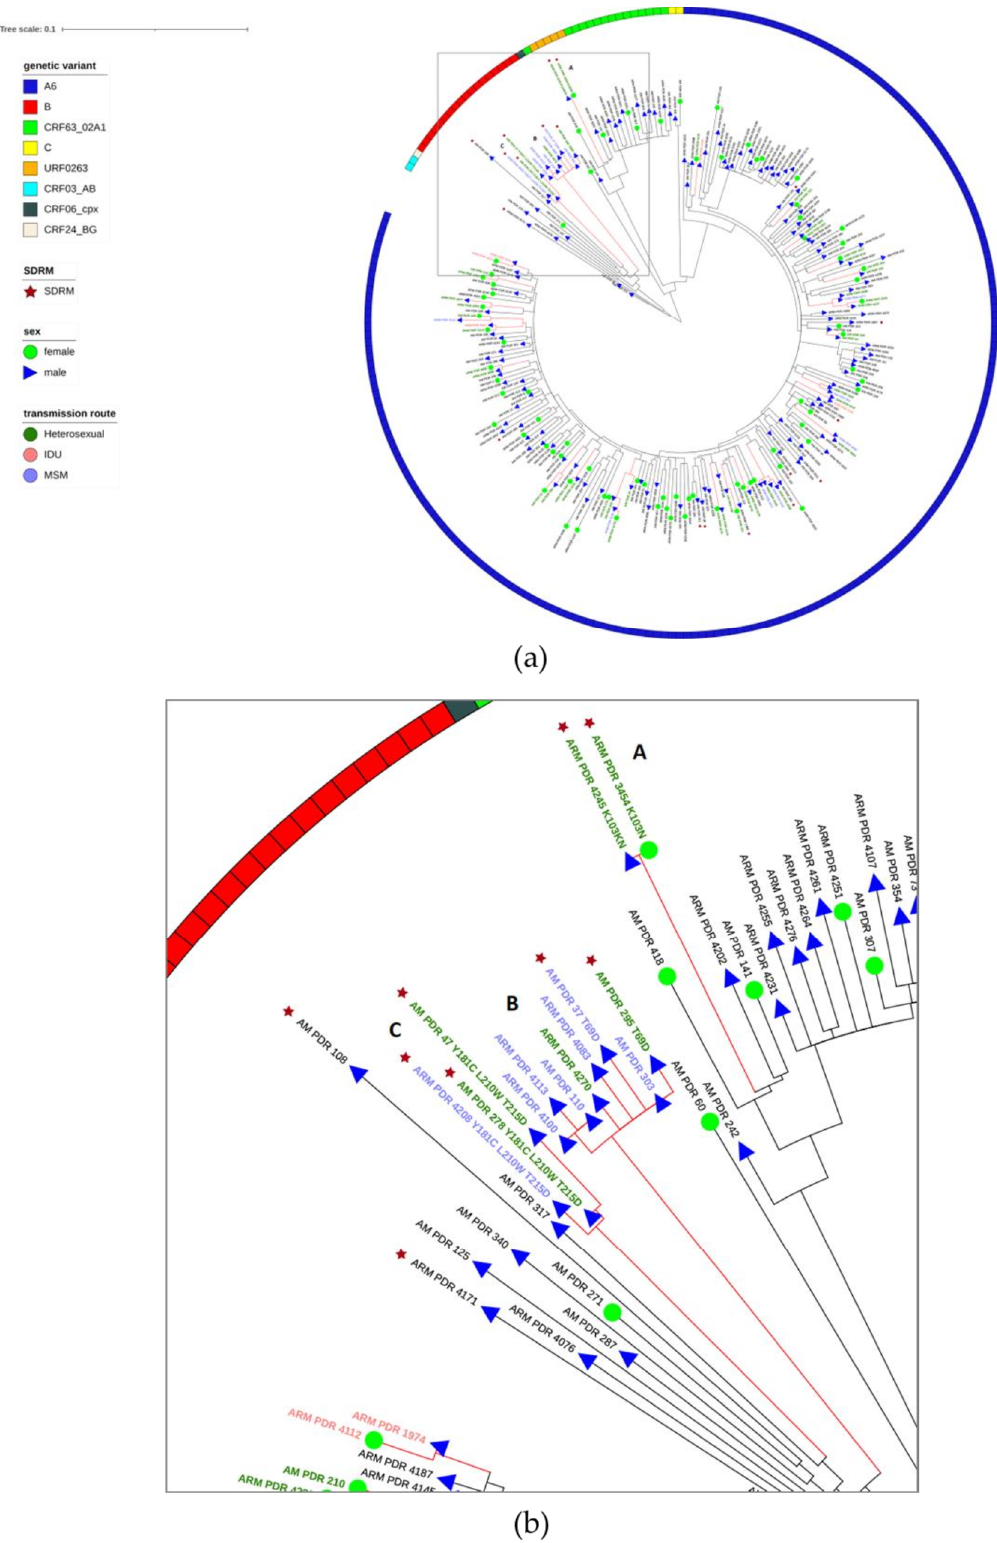
Figure 3. The maximum likelihood (ML) tree of the pol region sequences from both phases of study ( a ), with three clusters (A, B, and C) harboring shared surveillance drug resistant mutations (SDRMs) ( b ). Genetic variants are displayed on the outside of the tree (colored ring). Red branches